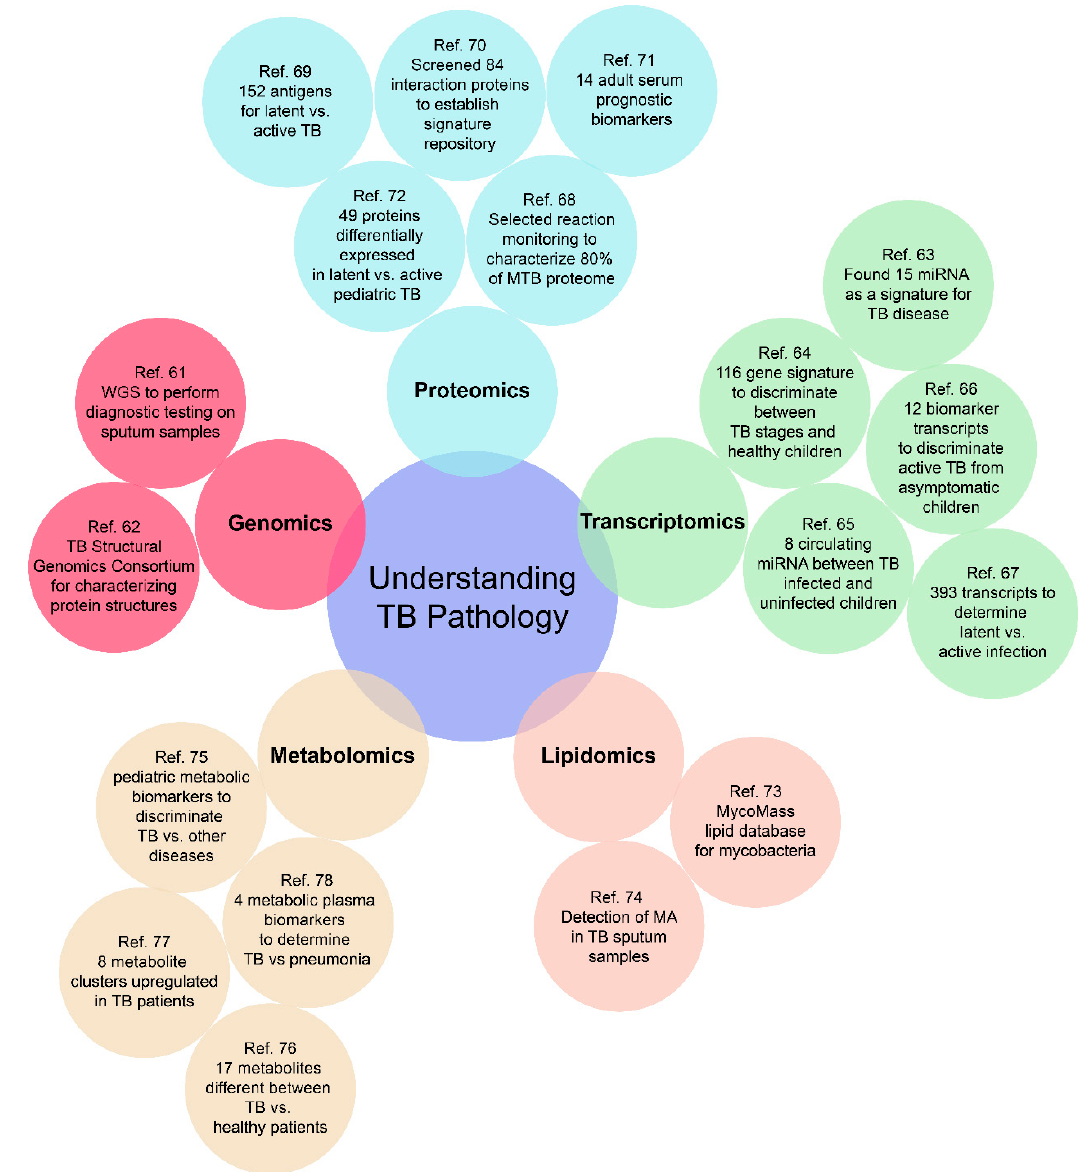
Figure 2. Representative cases for an “omics ‐ based” approach to build a comprehensive understanding of the pathology of both adult and pediatric TB. There are still many omics ‐ based approaches to be further investigated, especially for pediatric TB